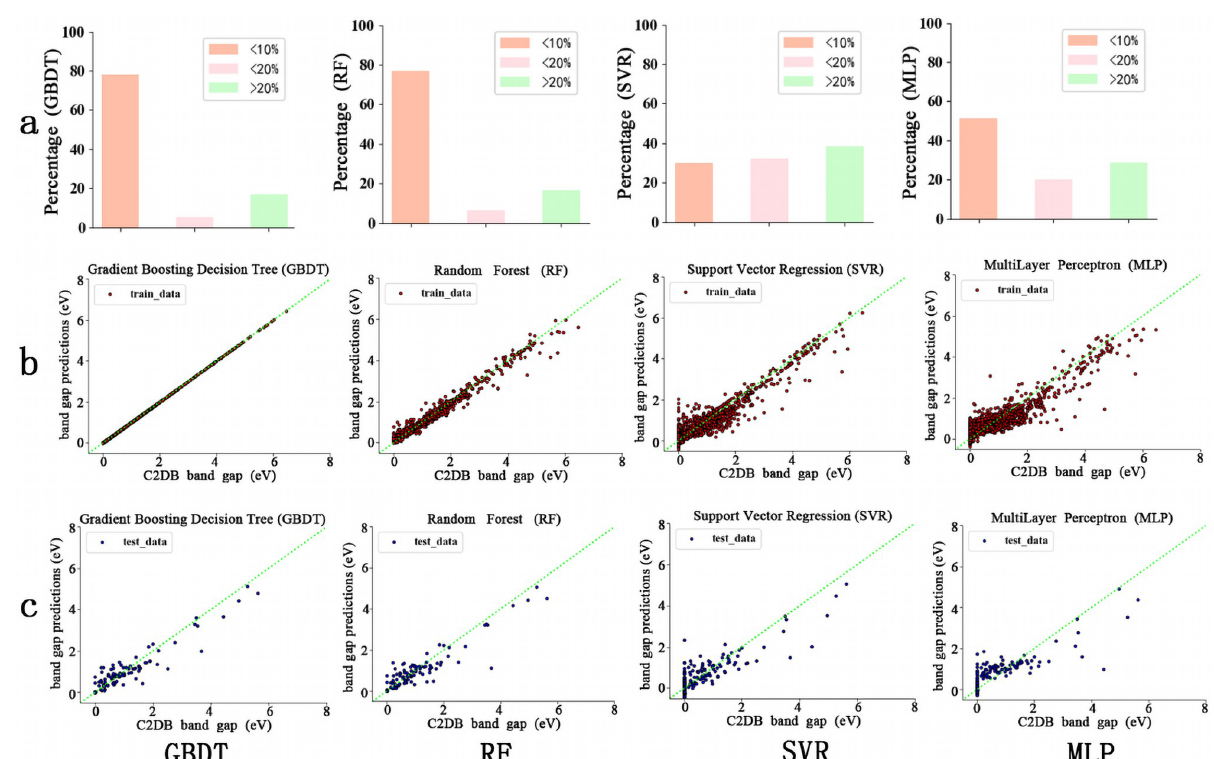
Fig 3. Prediction performance of four ML algorithms (GBDT, RF, SVR and MLP) without the feature Gap_nosoc. (a) Error levels of ML predicted bandgaps (b) Fitness between predicted bandgaps and true bandgaps on the training sets (c) Fitness between predicted bandgaps and true bandgaps on the test